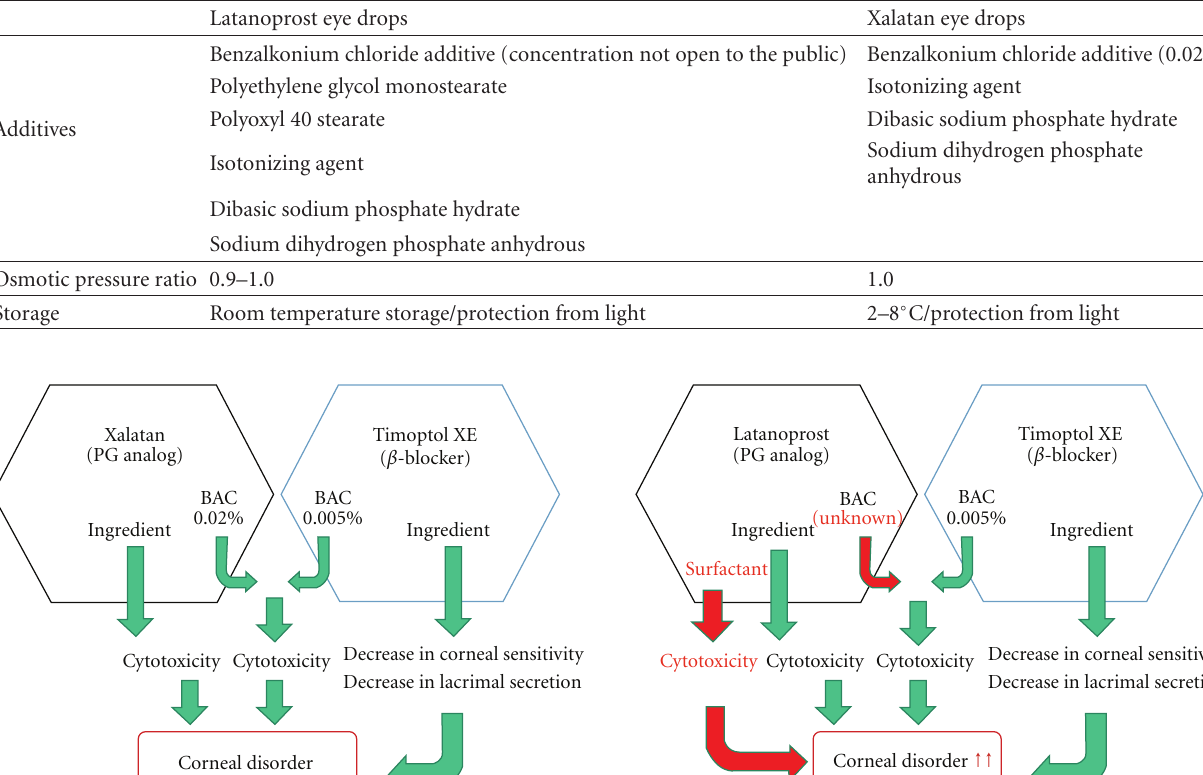
Table 1: Di ff erences between Latanoprost eye drops (Kaken pharmaceutical Co., Ltd.) and Xalatan eye drops.